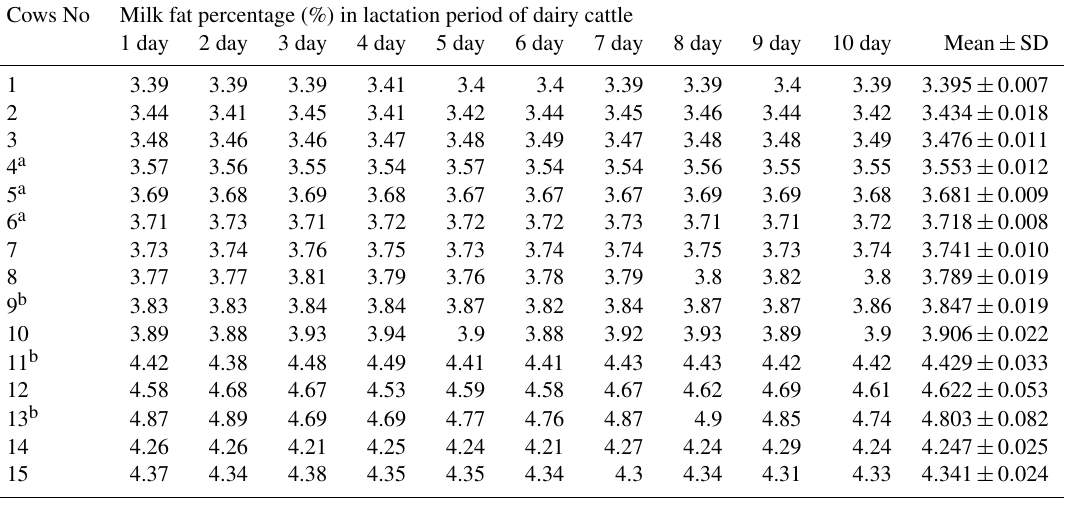
Table 2. The milk fat percentage data were obtained from a total of 15 Chinese Holstein dairy cattle 10 days continuously. Cows No Milk fat percentage (%) in lactation period of dairy cattle